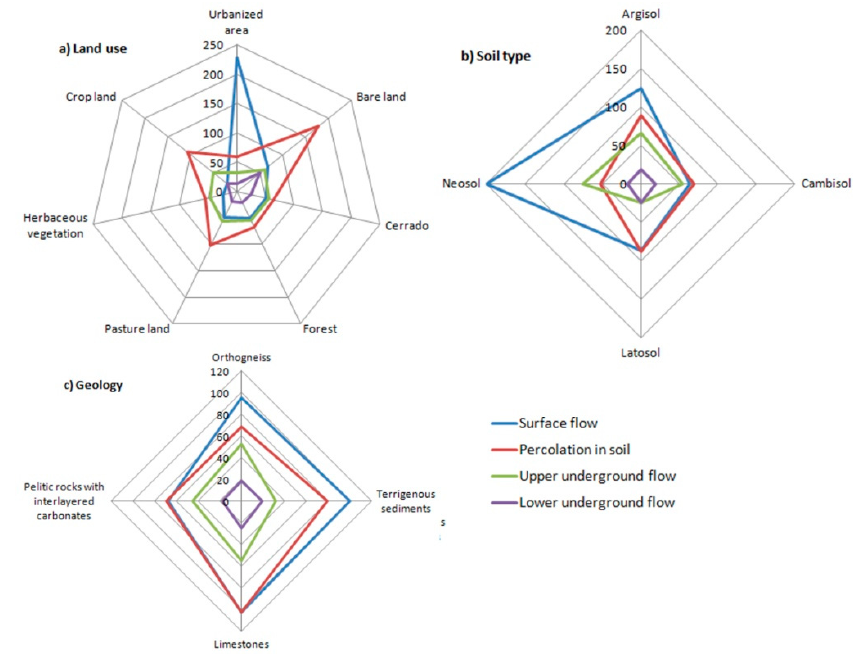
Figure 6. Distribution of stream flow components per land use ( a ), soil ( b ) and lithologic ( c ) types.